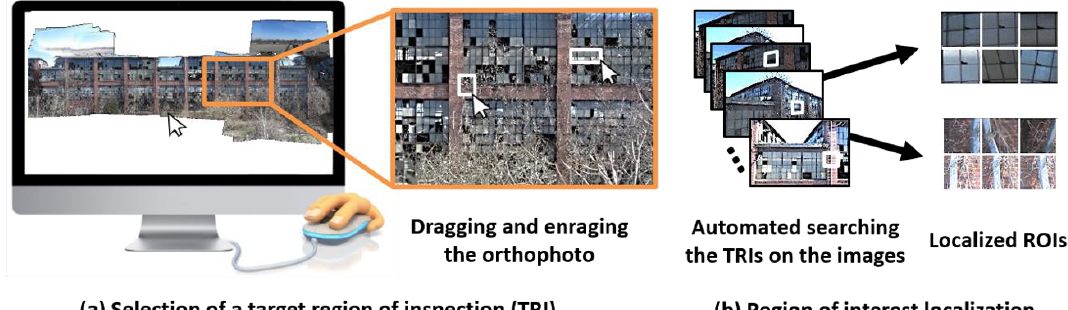
Figure 3. Region-of-interest localization procedure: ( a ) Selection of target regions of inspection (TRIs) and ( b ) Extraction of ROIs from raw collection of images.